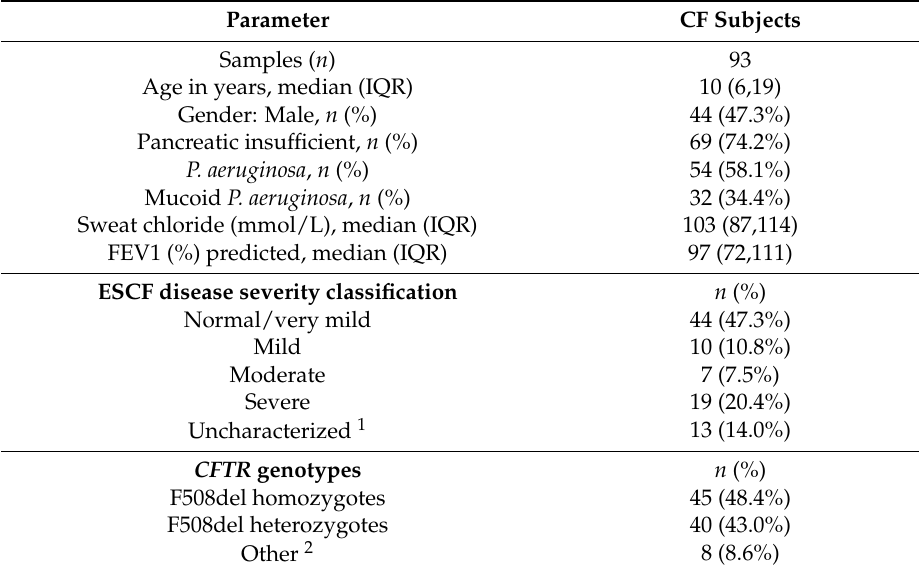
Table 1. Demographics of study subjects.